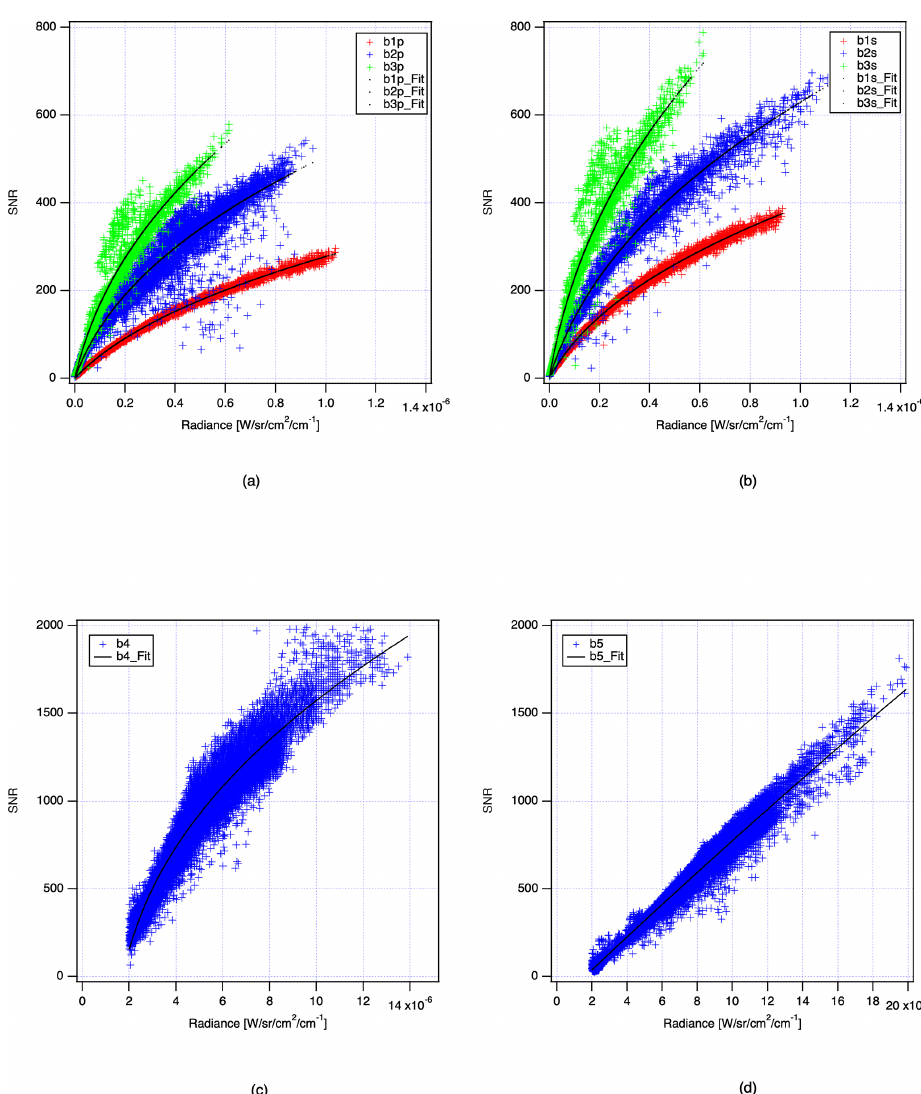
Figure 5. Signal-to-noise ratio calculated from in-orbit data: (a) p -polarization bands for bands 1, 2, and 3; (b) s -polarization band for bands 1, 2, and 3; and (c) band 4 and (d) band 5. Black dots show the model